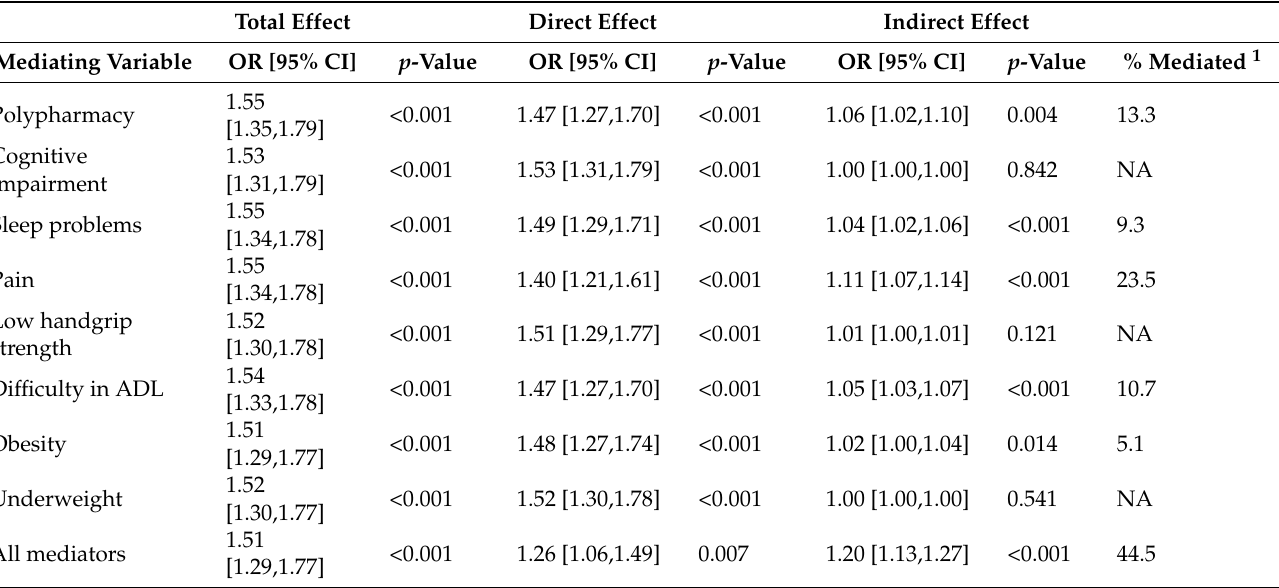
Table 3. Mediating variables in the prospective association between multimorbidity (i.e., ≥ 2 chronic conditions) at baseline and falls at